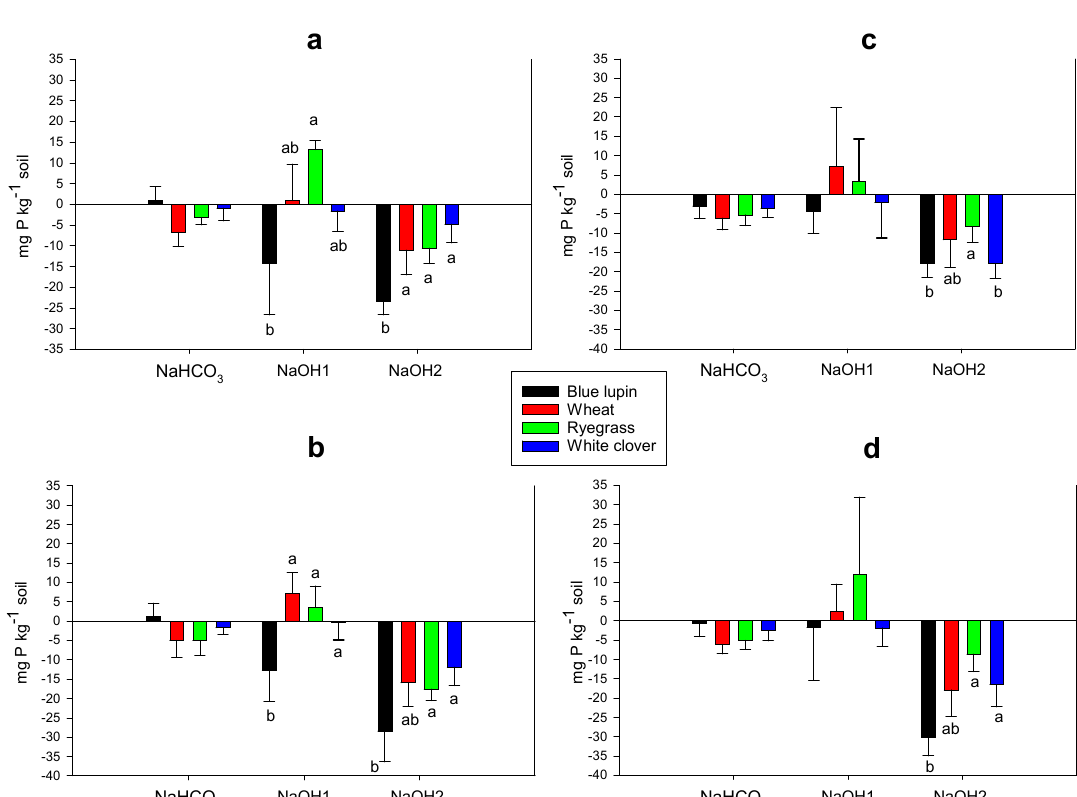
Figure 5. Changes (depletion or accumulation) in different organic P fractions with the control conditions ( a ), P treatment ( b ), N treatment ( c ), and NP treatment ( d ) in the rhizospheres of blue lupin, wheat, ryegrass and white clover. Different letters denote a significant difference ( p < 0.05) among plant species for a given nutrient treatment.